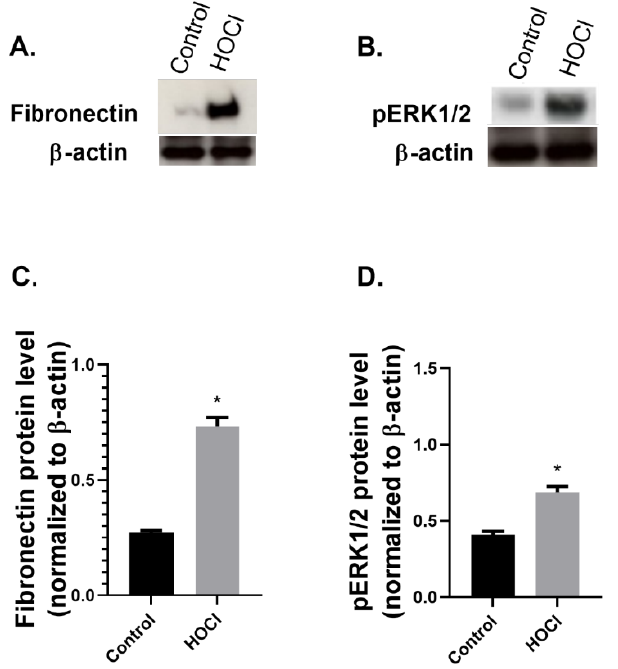
Figure 4. Increased molecular markers of fibrosis in skin fibrosis animal model. BALB/c mice were administered intra-dermal injections of 100 μL hypochlorite (HOCL) daily for 6 weeks. Mice were culled and ( A ) Fibronectin and ( B ) pERK1/2 or β -actin loading control protein levels were assessed by Western blot in fibrotic skin tissue. Densitometry analysis of ( C ) Fibronectin and ( D ) pERK1/2 expression from Western blot. The graphs present representative data from one experiment with n = 7 (Control) and n = 8 (HOCL) mice per group. Results are presented as mean ± SEM. Statistical analysis was performed by Mann–Whitney test (one-tailed). * p ≤ 0.05 vs. control.